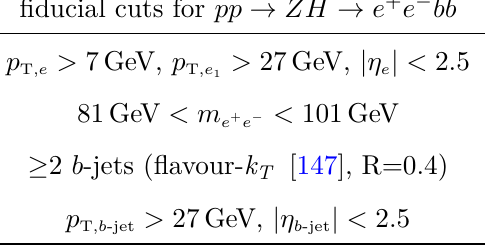
Table 1 . Fiducial cuts for e + e − b ¯ b production from ref.